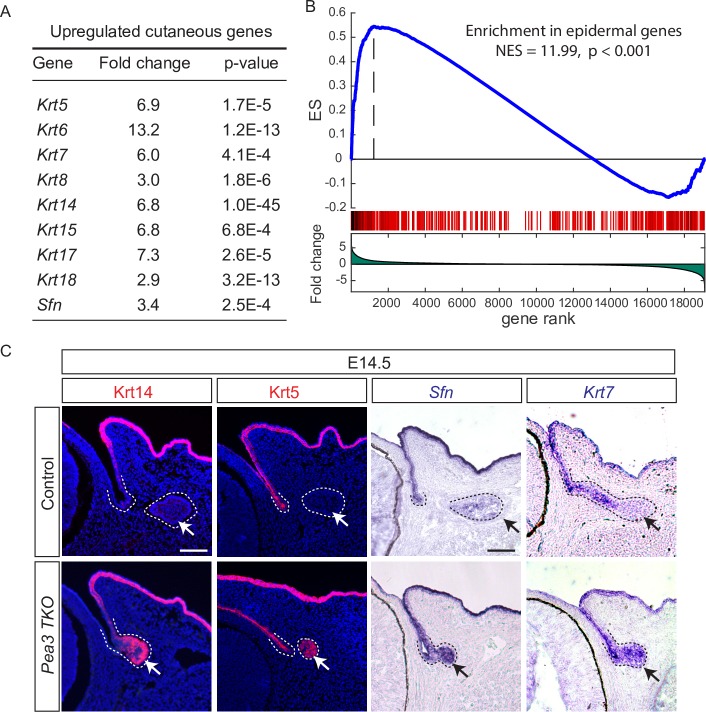
Loss of Pea3 disrupted the adoption of the lacrimal gland fate.(A) A list of genes typically expressed in the cutaneous epithelium that were upregulated in the Pea3 TKO lacrimal gland bud. (B) GSEA analysis of differentially upregulated genes in the Pea3 TKO mutants showed a strong resemblance to the epidermal gene signature. (C) Ectopic expression of Krt14, Krt5, Sfn and Krt7 in the Pea3 mutant lacrimal gland. Scale bars, 50μm.